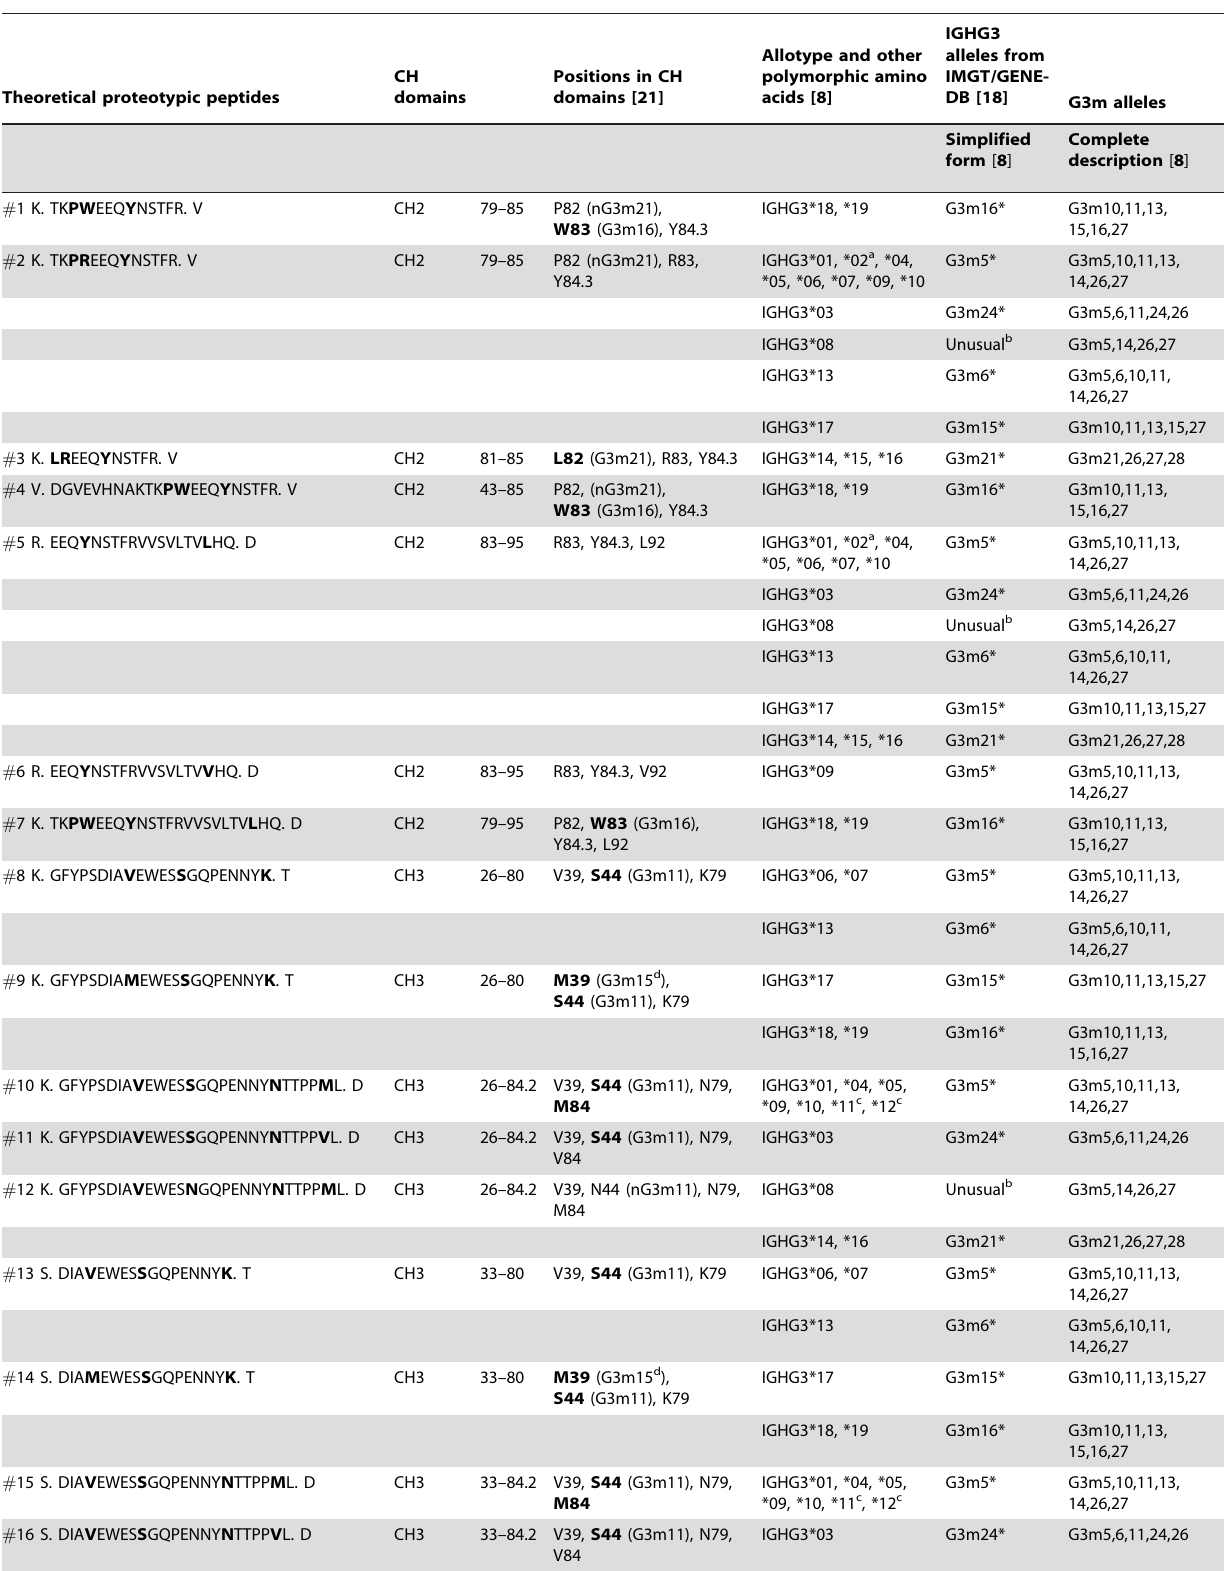
Table 2. Characteristics of the thirty-two proteotypic peptides for Homo sapiens G3m and IGHG3